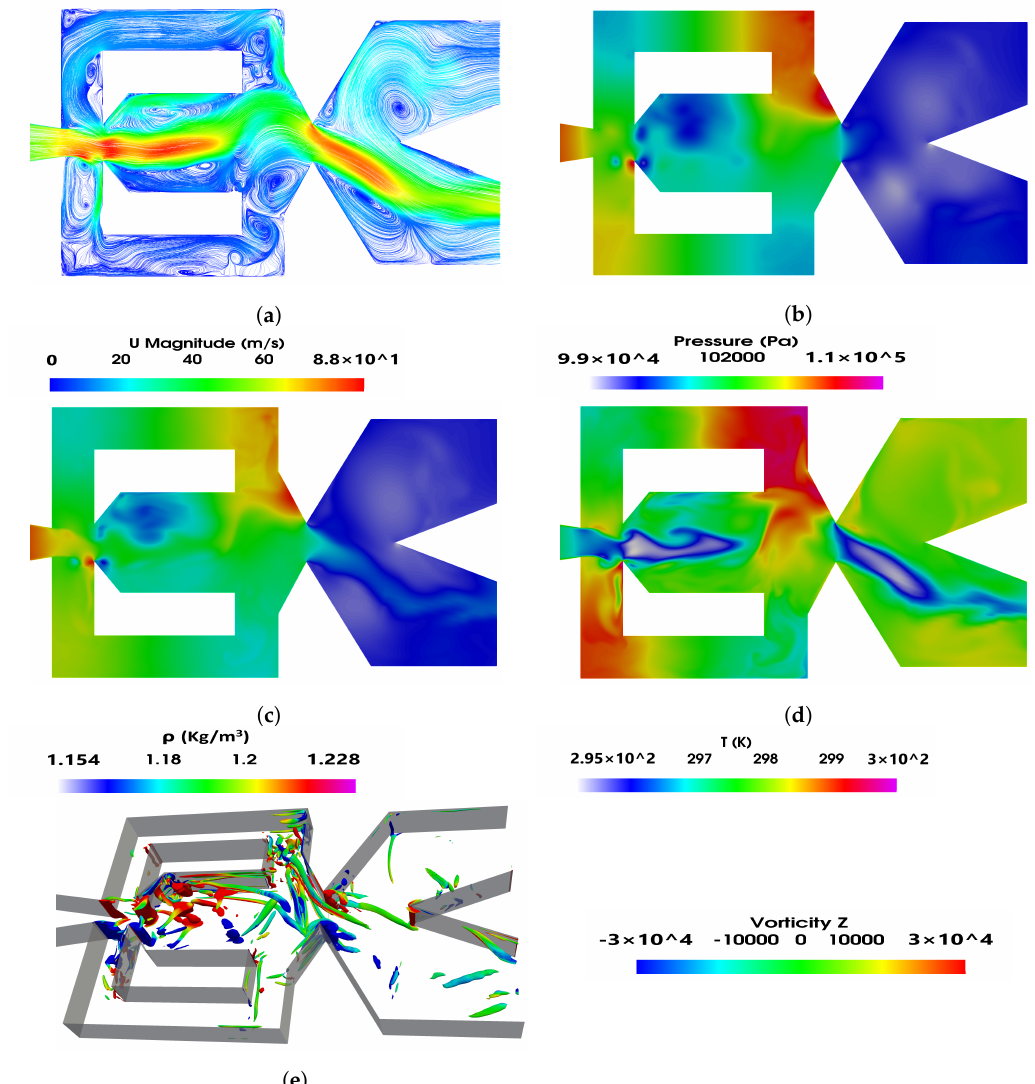
Figure 6. Mixing chamber instant velocity field ( a ), pressure distribution ( b ), density ( c ), temperature ( d ) and ( e ) Q criterion fields. Power nozzle velocity 65 m/s. Baseline